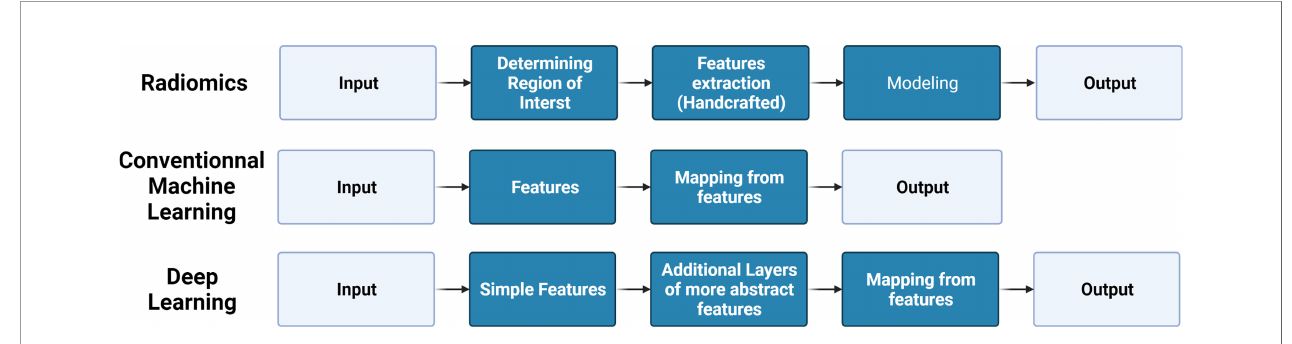
FIGURE 2 | Brief comparison of the pipeline of radiomics, conventional machine learning, and deep